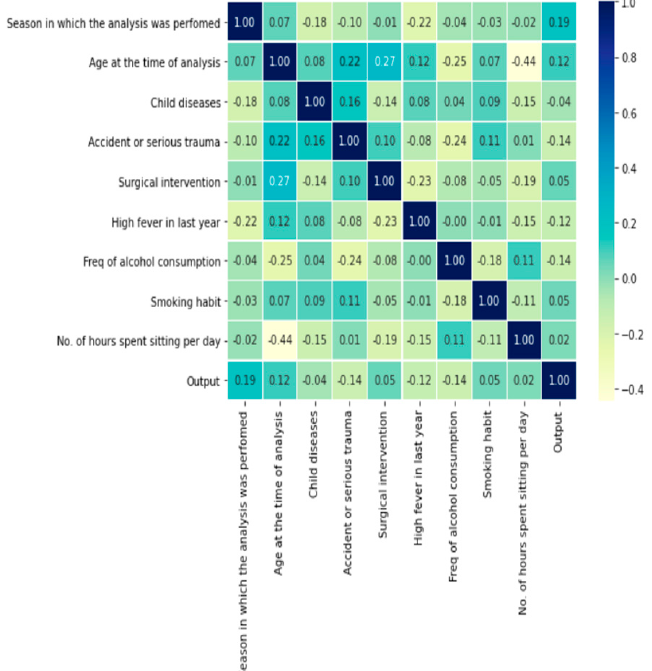
Figure 2. Measure of relationship using correlation. Table 3. Correlation values of the dataset.